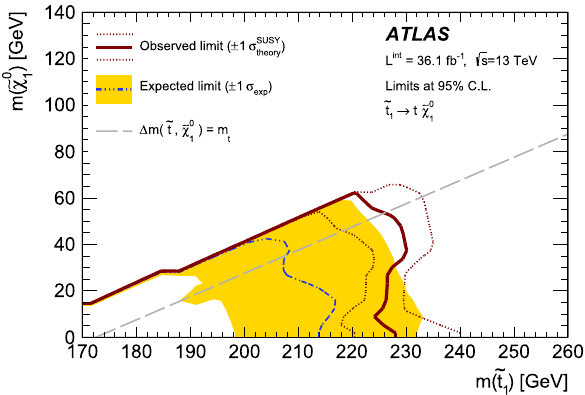
Fig. 17 Expected and observed limits at 95% CL on the top squark pair production cross-section as a function of m ˜ χ 0 100% branching ratio for ˜ t 1 → t ˜ χ 0